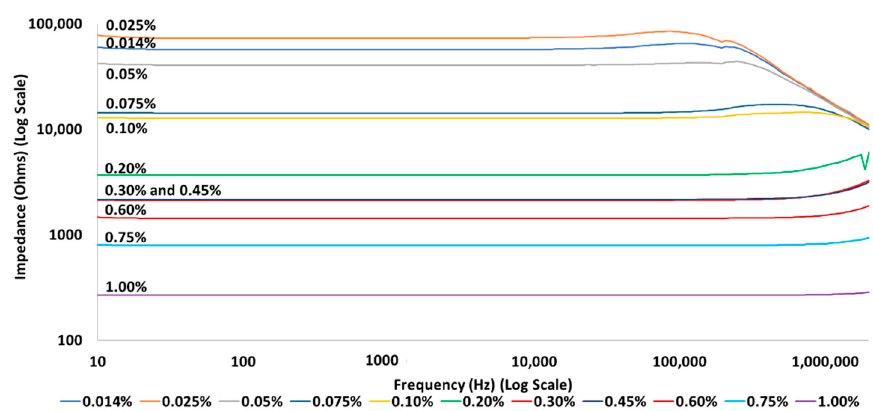
Figure 2. Log plot of impedance vs. frequency for various CNT loadings .